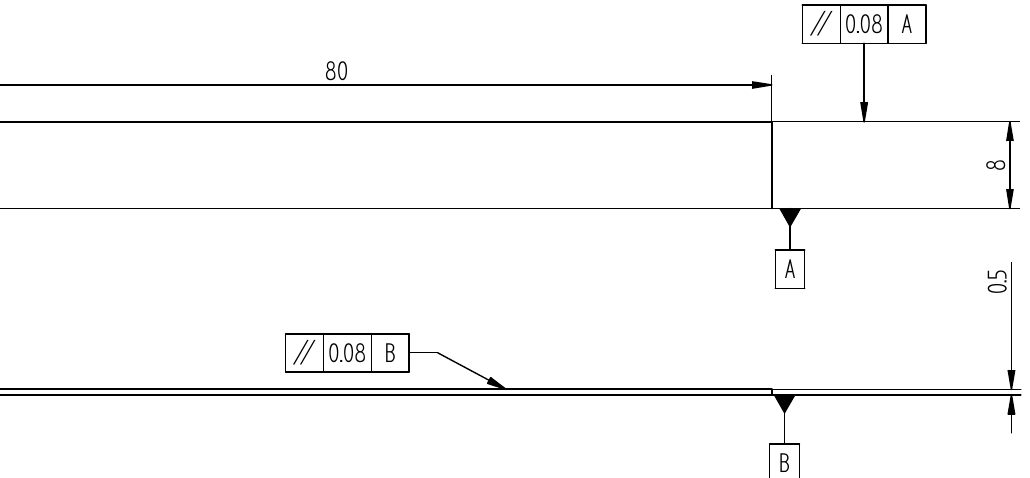
Figure 11. Geometry of the tensile specimen in accordance with the ASTM D3039 used for testing unreinforced specimens. Commonly used in technical drawings, A and B are the reference surfaces for the parallel tolerances as seen in the ASTM